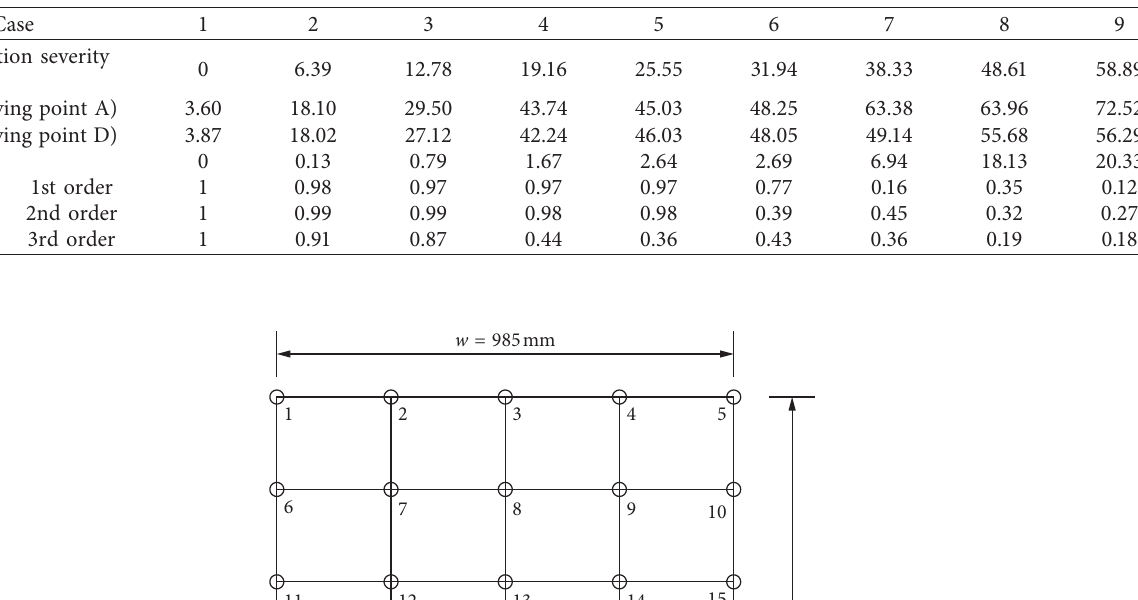
Table 3: E a , E ω 1 , and MAC.